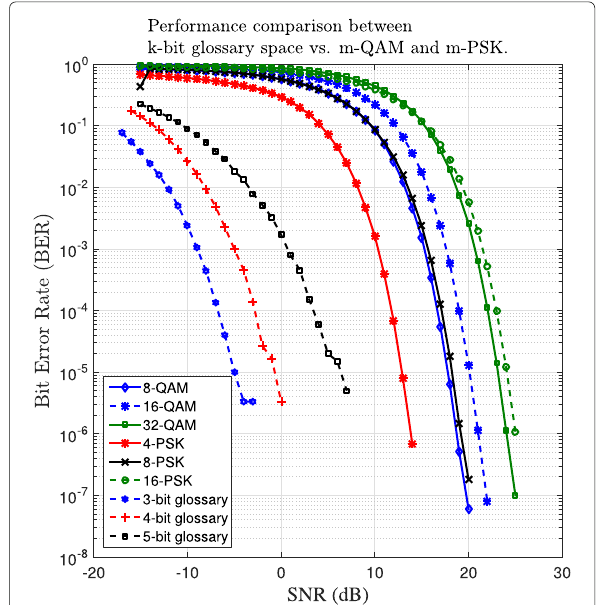
Fig. 13 The simulated performance of PBCCS and m -QAM in an AWGN channel. The neural network contains 20 hidden